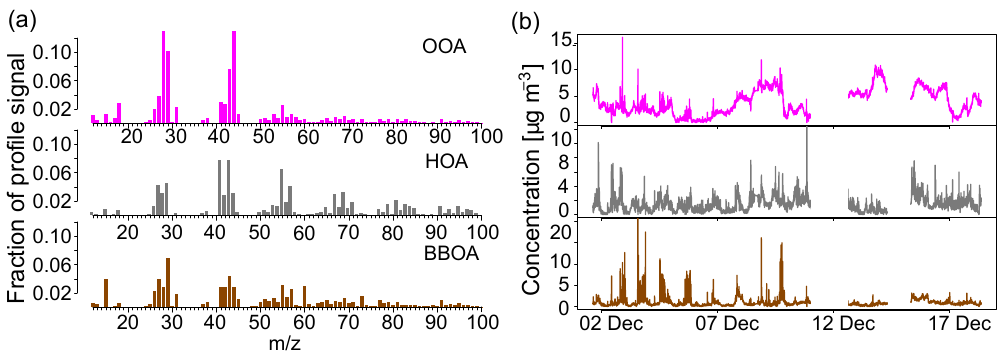
Fig. 8. PMF results for AMS data, (a) factor profiles, from top to bottom: oxygenated (OOA), hydrocarbon-like (HOA) and biomass burning (BBOA) organic aerosol. The solid bars (left y -axis) represent the amount of each species apportioned to the factor, (b) corresponding time series.